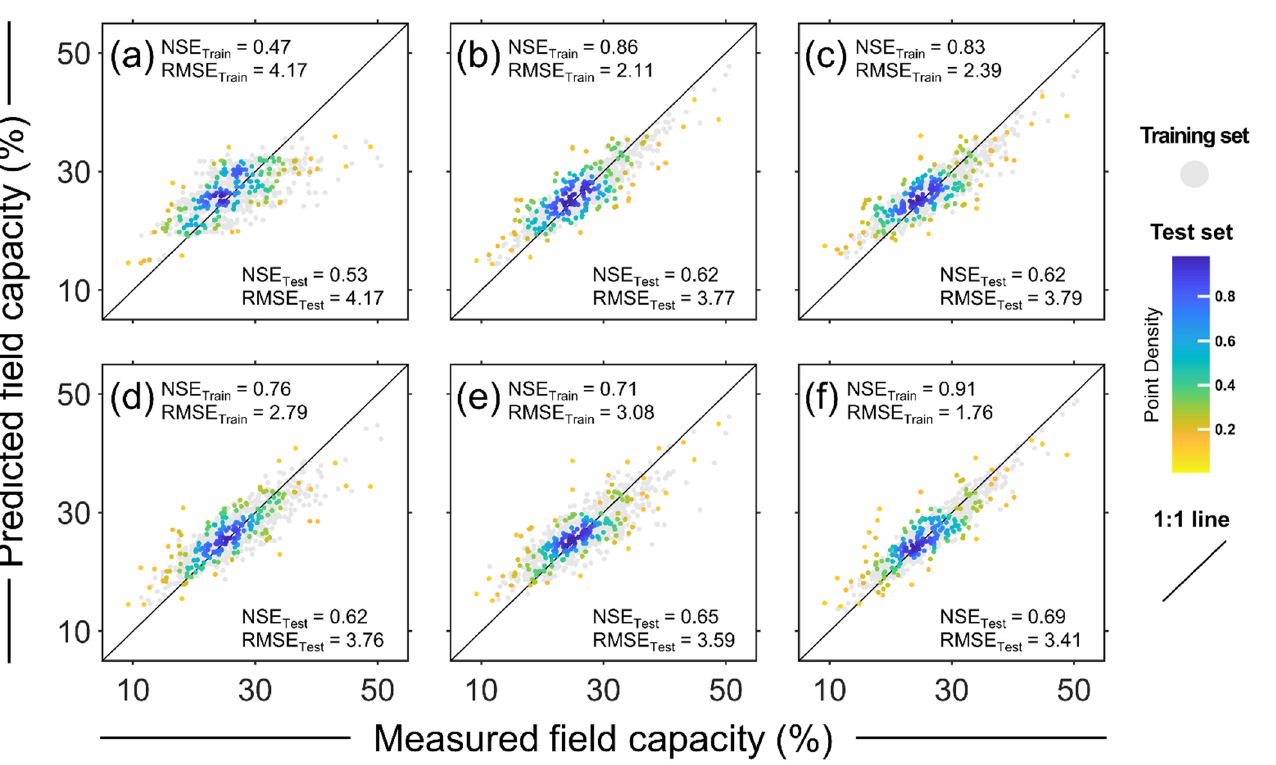
Figure 5. Relationship between measured and predicted field capacities according to the six predictor set hierarchies. Training sets are plotted with gray points, and test sets are plotted in yellow-to- blue. Five-fold cross-validation was performed for model performance with the ( a ) E4-S0-based RF, ( b ) E12-S0-based RF, ( c ) E14-S0-based RF, ( d ) E0-S4-based GB, ( e ) E14-S2-based GB, and ( f ) E14-S4- based GB models.